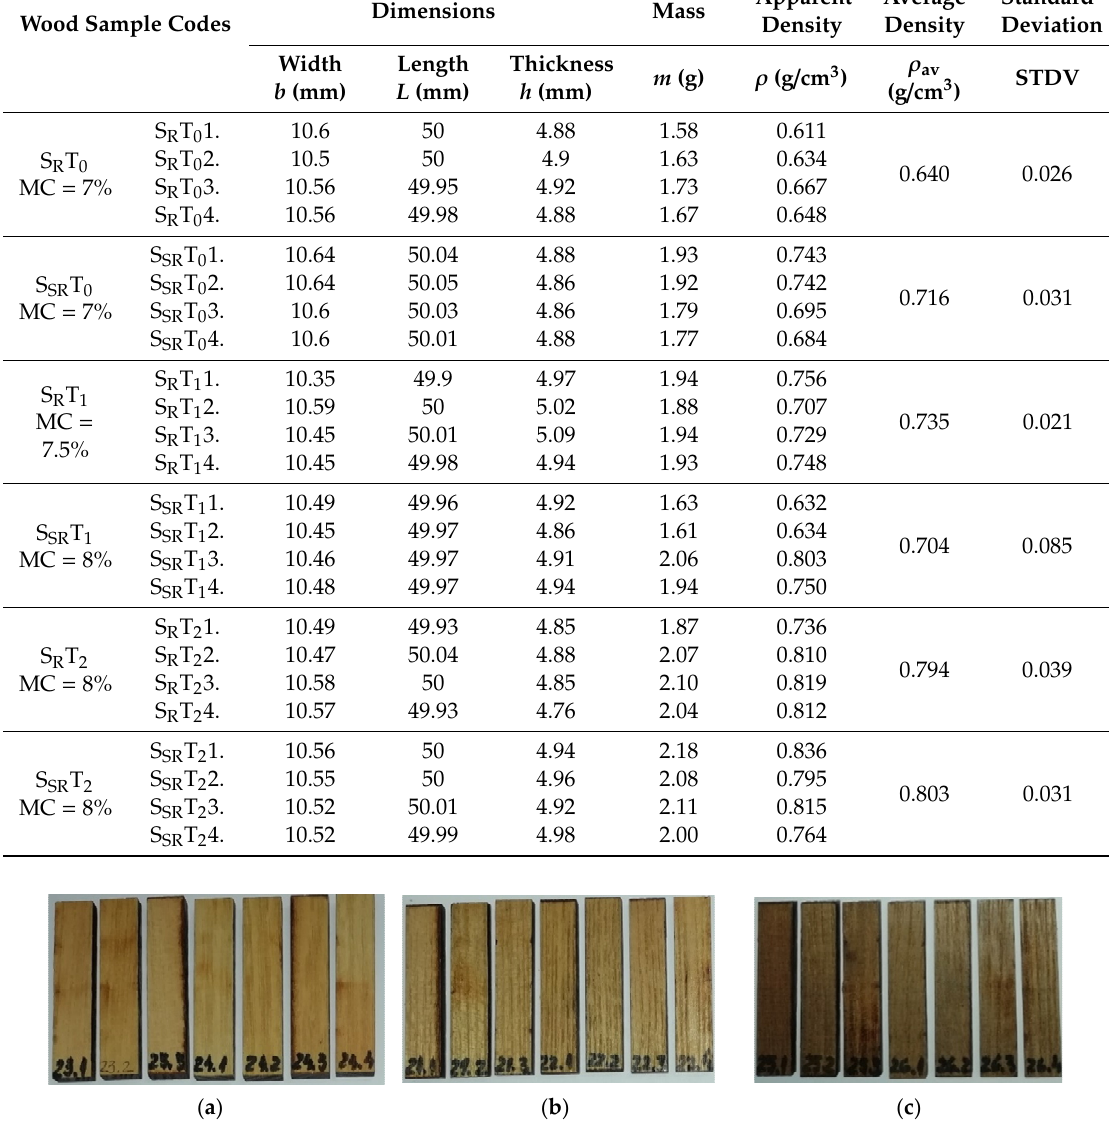
Table 1. Physical characteristics of wood samples prepared for dynamic mechanical analysis (DMA) test. Wood Sample Codes